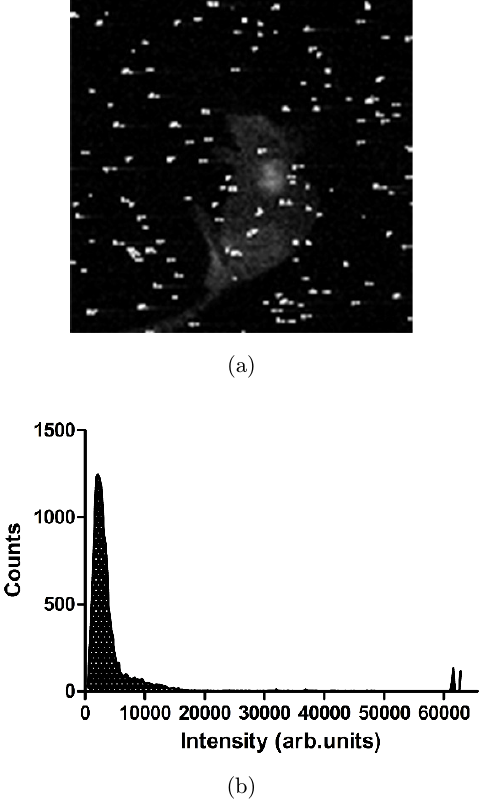
Fig. 1. (a) A CLI image of in vivo experiment and (b) the histogram of